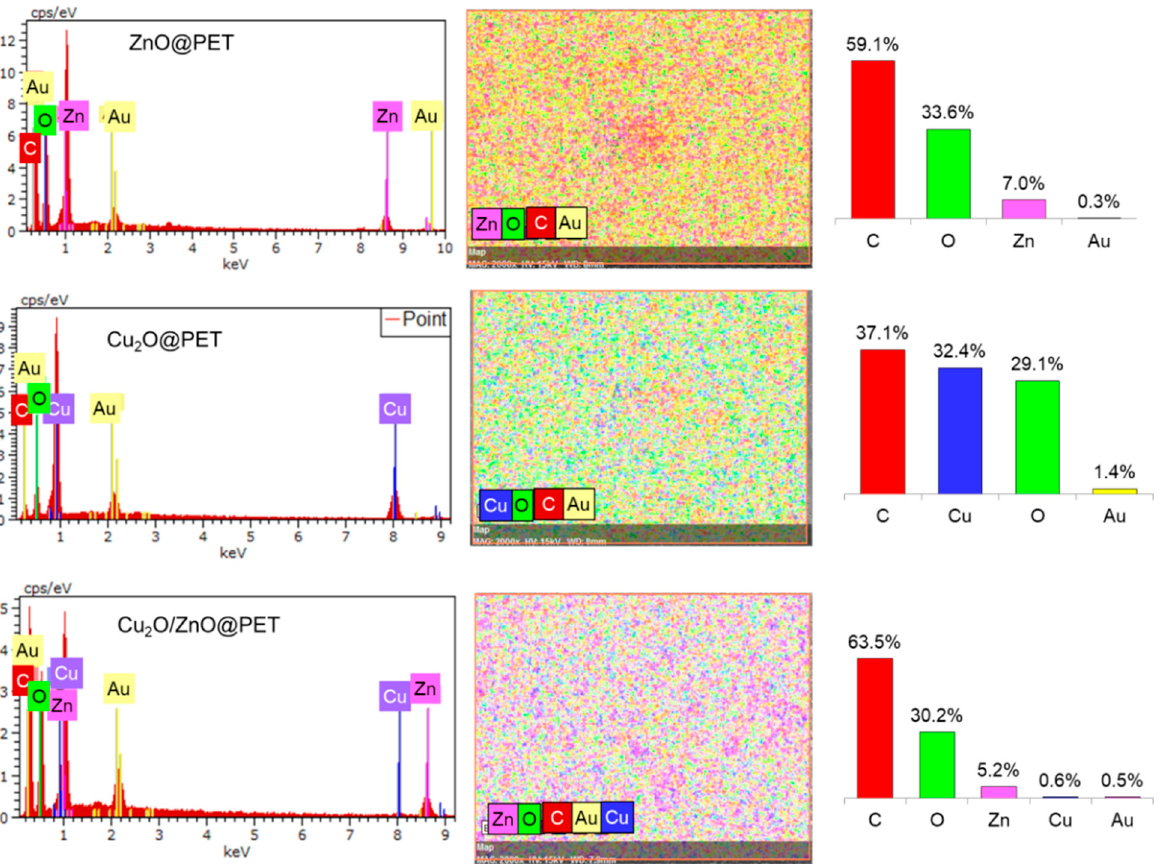
Figure 2. EDS spectra, elemental mappings and corresponding atomic percentages of the synthesized composite TeMs.